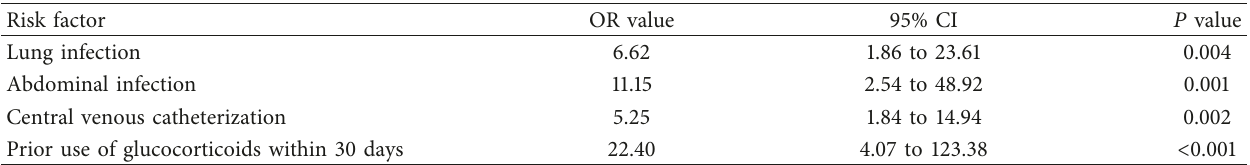
Table 4: Logistic regression analysis of risk factors for mortality in patients with Enterobacteriaceae bloodstream infections. Risk